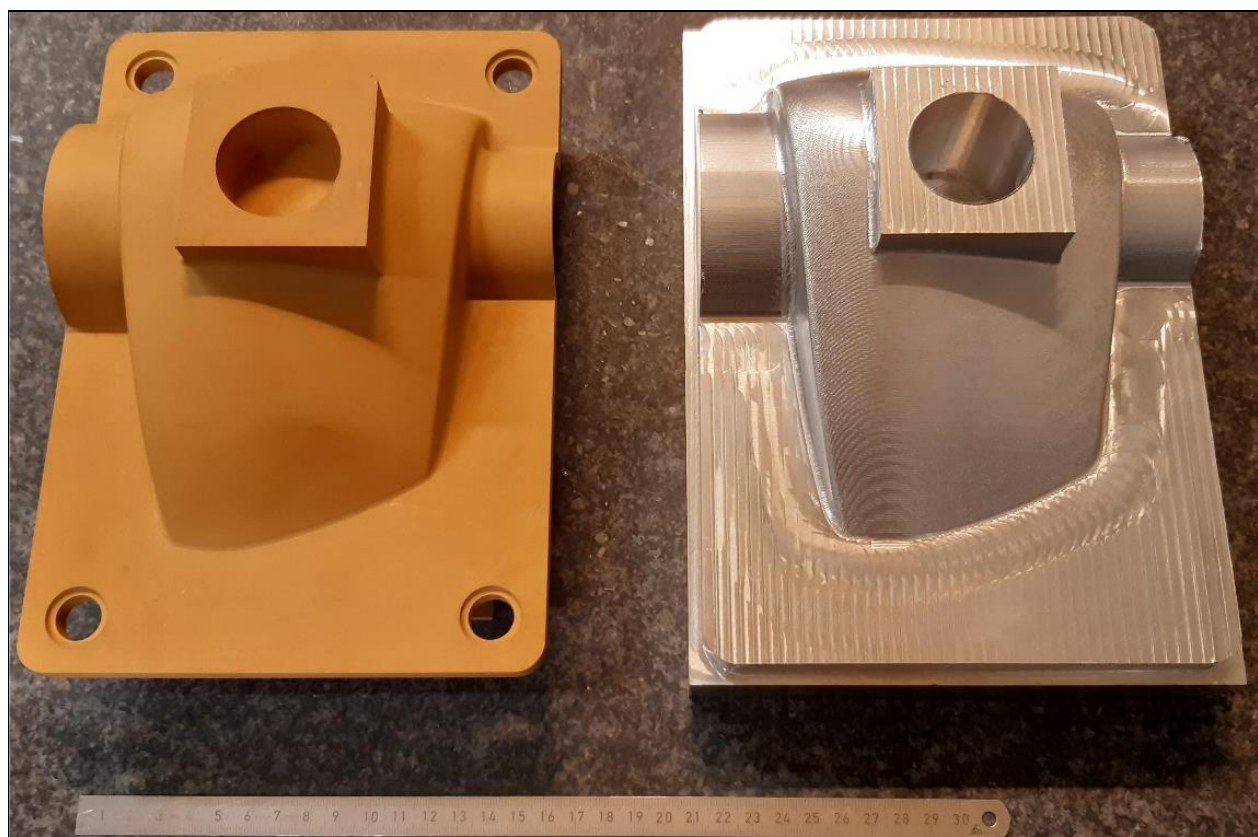
Figure 10. The validation objects with different surface characteristics, with the matte object on the left and the reflective object on the right. The measurement volume is about 250, 180 and 95 mm in the x-, y- and z-direction, respectively.